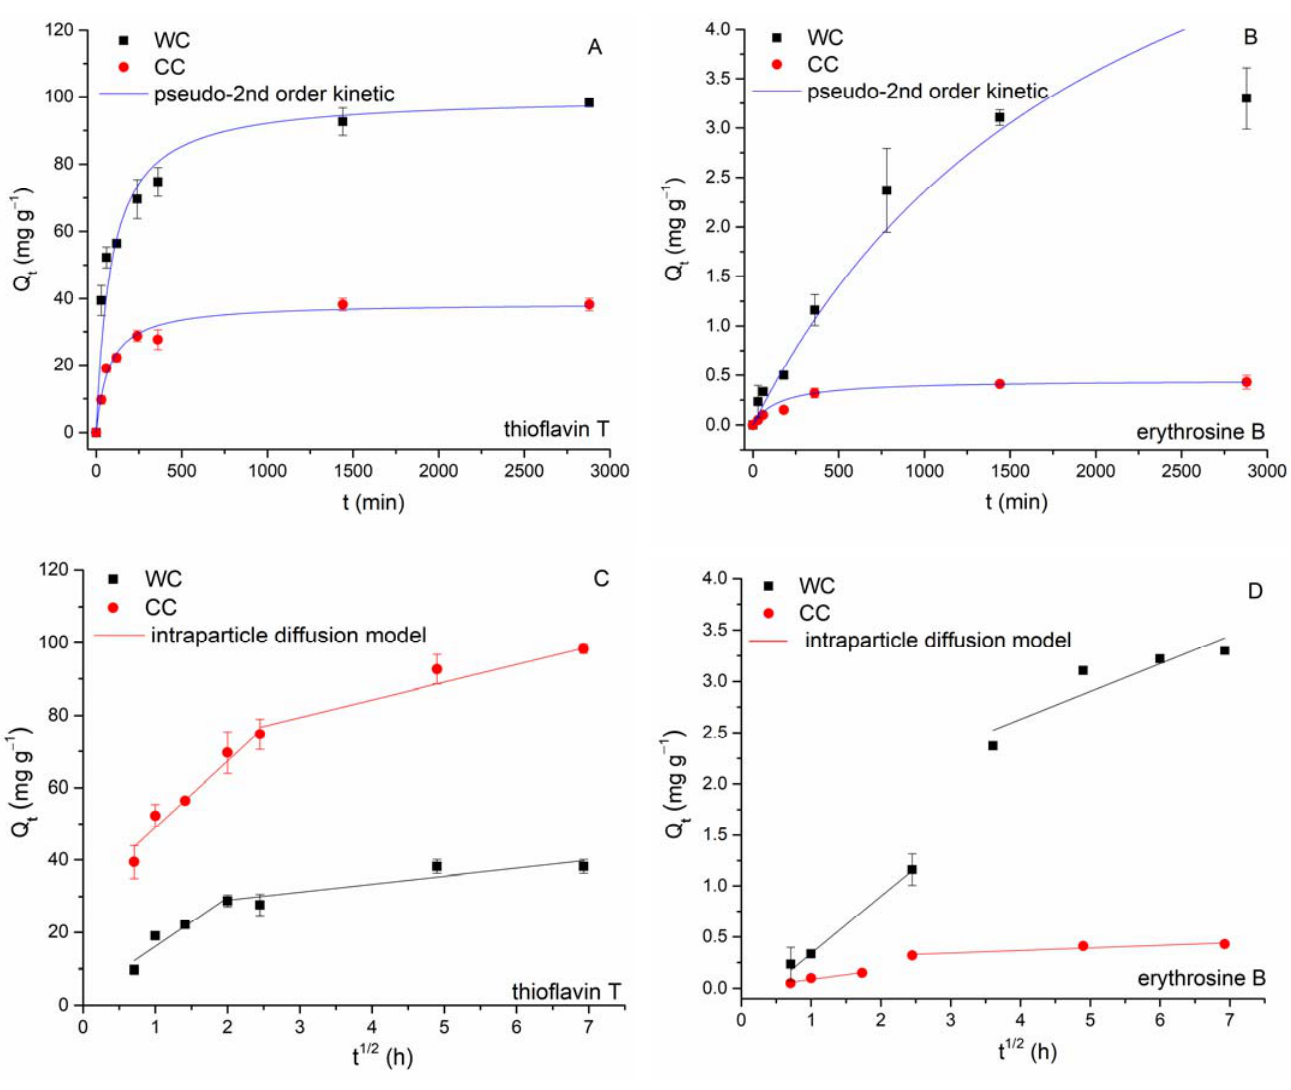
Figure 8. Effect of the reaction time on TT (C 0 = 100 mg L − 1 , ( A )) and EB (C 0 = 43 mg L − 1 , ( B )) adsorption by wood-chip and corn-cob biochars (8.3 g L − 1 ; pH 6.0; T = 22 ◦ C). Adsorption kinetics fitting by pseudo-second-order ( A , B ) and intraparticle-diffusion ( C , D ) models.